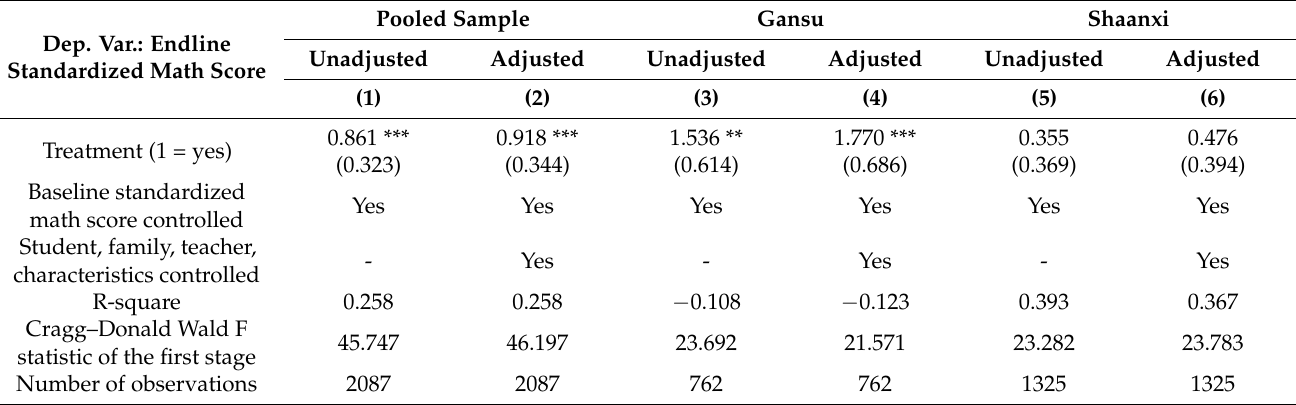
Table 5. Impact of wearing eyeglasses on endline standardized mathematics score